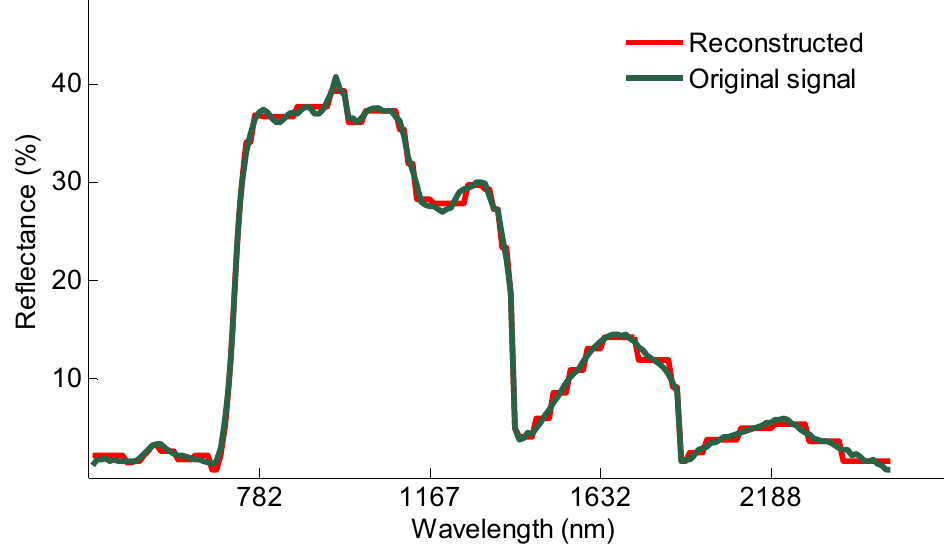
Figure 6. Reconstructed (with Haar coefficients having cumulative 99.99% energy) versus original signal for one of the